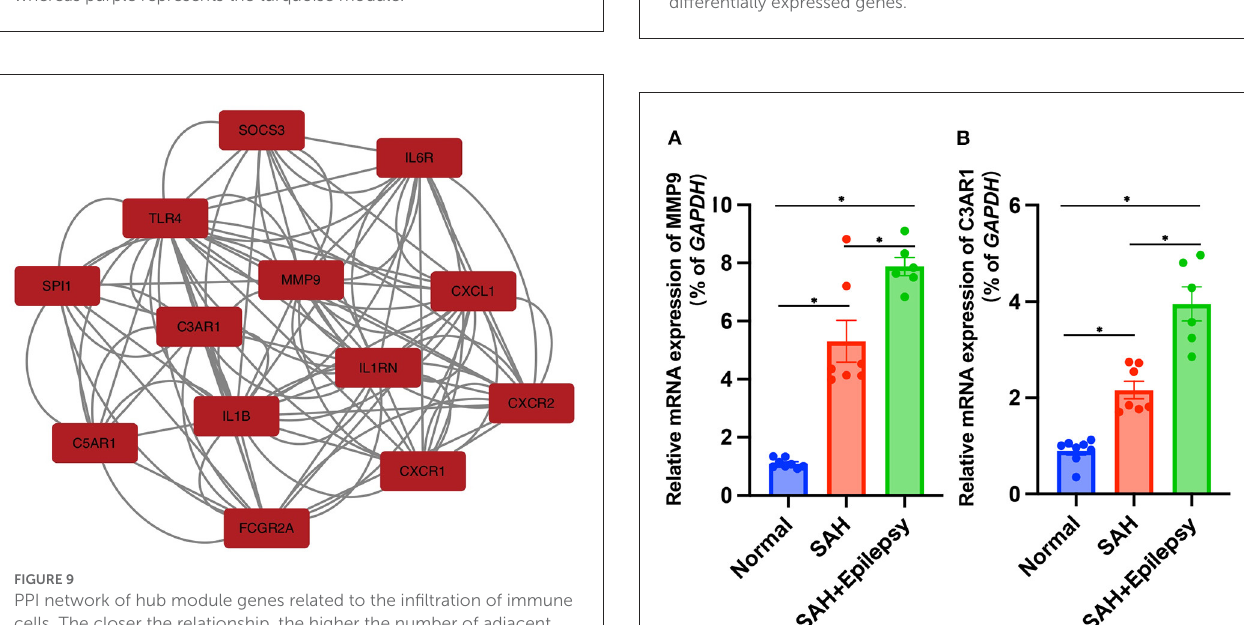
FIGURE8 Intersecting genes of the dark red and black modules and the turquoise module. Red represents the dark red and black modules, whereas purple represents the turquoise module.